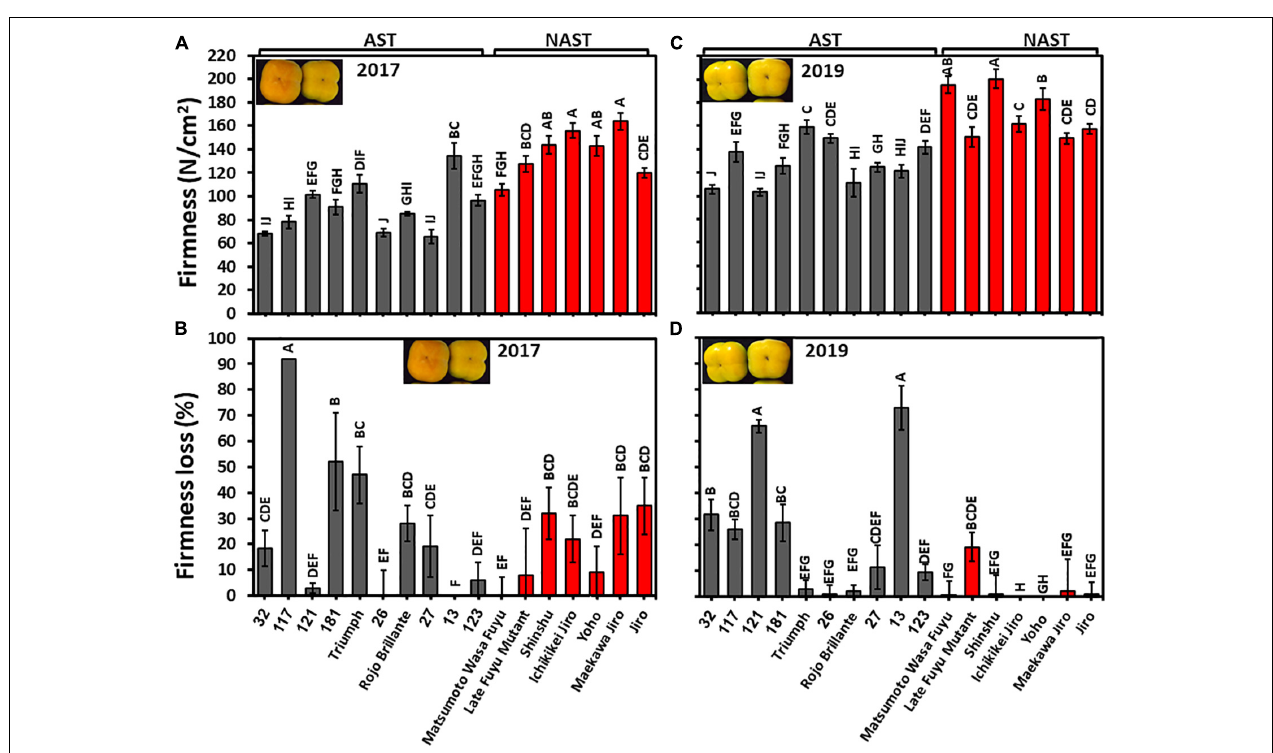
FIGURE 7 | Firmness at harvest and firmness loss following 3 months of storage. (A) Firmness of harvest 2017 and (C) for harvest 2019. (B) Firmness loss of harvest 2017 and (D) for harvest 2019. Firmness loss was determined following 3 months of storage at 0 ◦ C. Bars show the average of 5 fruits in 2 places; ± SE. Different letters indicate a significant difference between treatments according to the Tukey-Kramer HSD test at p ≤